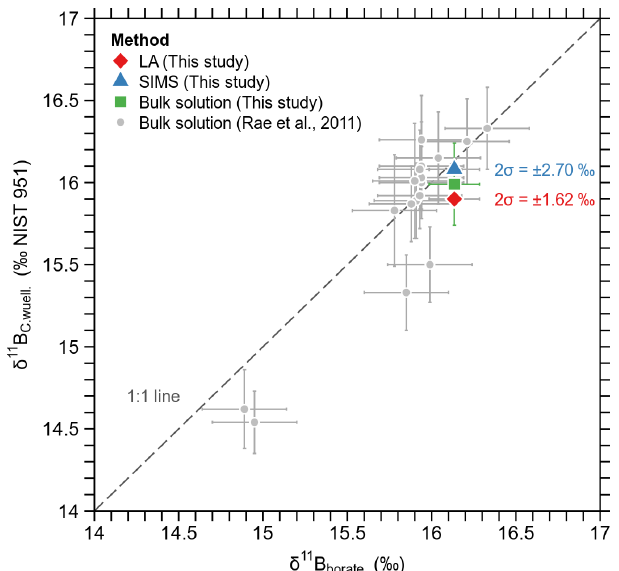
Figure 7. Results from Monte Carlo simulations of 2 σ uncertainty for δ 11 B using LA-MC-ICPMS in relation to the number of ana- lyzed C. wuellerstorfi shells ( n ). In red is the estimated uncertainty based on “large crater”, and in blue on “umbilical knob” measure- ments (see inset scanning electron microscope picture for different areas). The estimated 2 σ uncertainty can be described by a function of the quoted uncertainty ( u q ) and n (Eq.